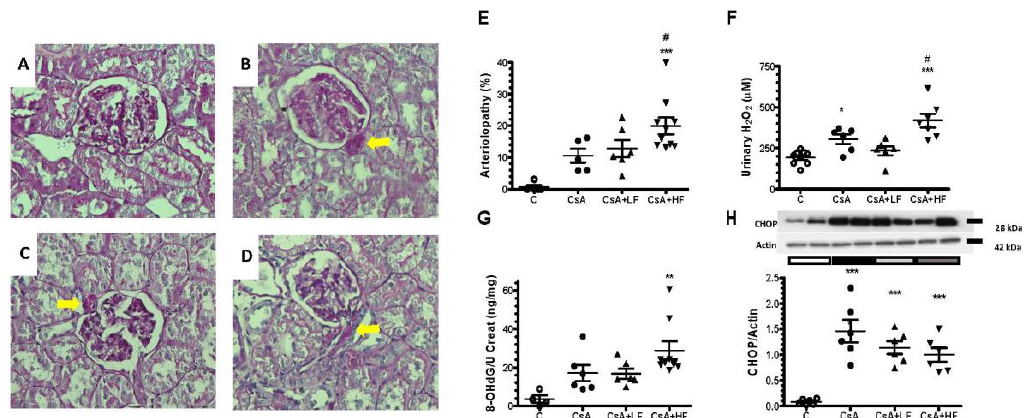
Figure 3. High doses of fosfomycin enhance oxidative stress and arteriolopathy induced by CsA. Representative images of periodic acid-Schiff (PAS) staining: ( A ) control, ( B ) CsA, ( C ) CsA + LF, and ( D ) CsA + HF groups (magnification: 400×). ( E ) The percentage of arteriolopathy, ( F ) urinary H 2 O 2 , ( G ) urinary 8-OHdG excretion, and ( H ) of CCAAT/enhancer-binding protein homologous protein (CHOP) expression were evaluated in control (C, white circles), cyclosporine (CsA, black circles), CsA with a low dose of fosfomycin (CsA + LF, black triangles up), and CsA with a high dose of